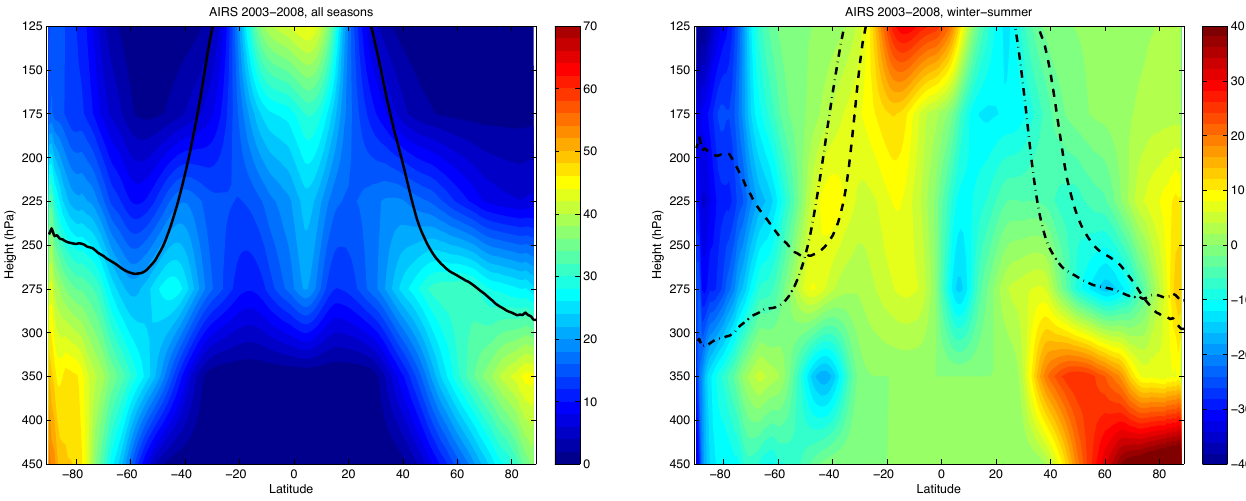
Fig. 11. Zonal means of ice supersaturation occurrence frequencies (%) from AIRS using S 100 ( RHi A ) (left) along with boreal winter minus boreal summer differences (right). Plain line: zonal-mean tropopause (all seasons). Dashed line: zonal mean summer tropopause. Pointed dashed line: zonal mean winter tropopause. Only good quality data used. 7-yr statistics